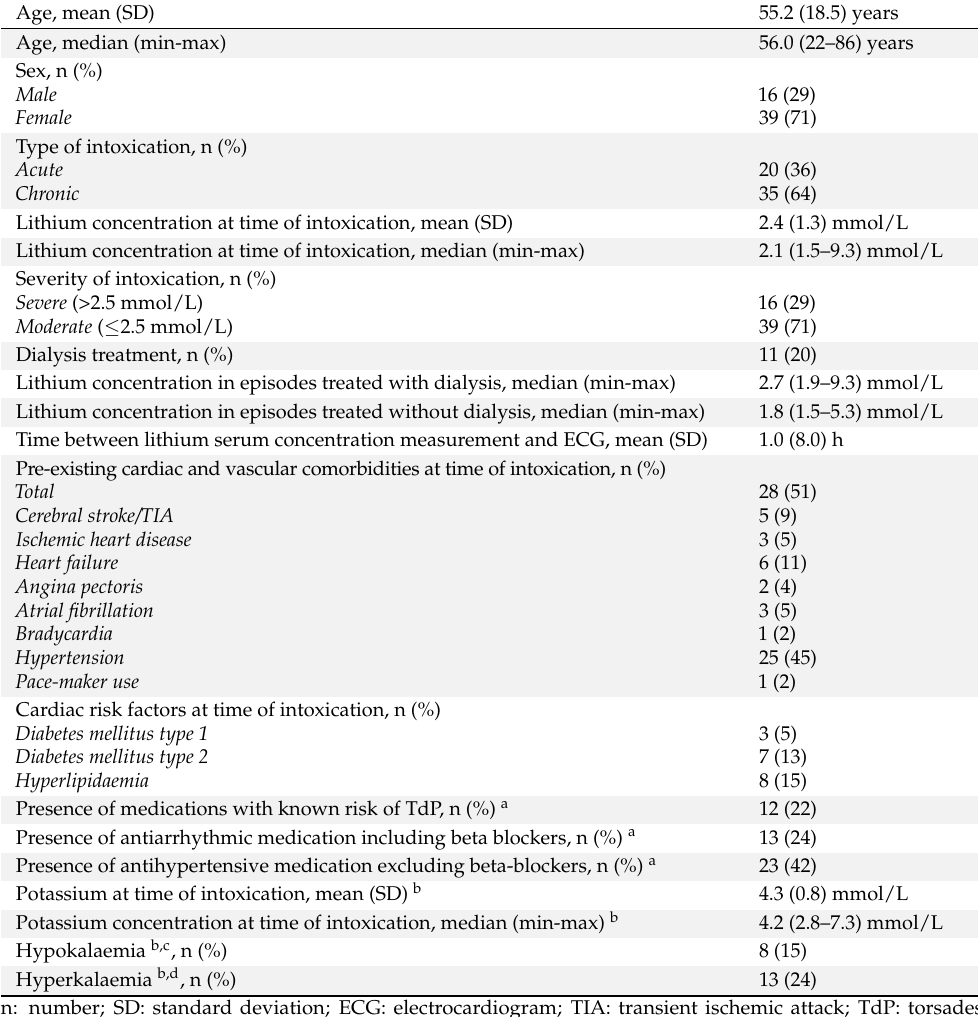
Table 3. Baseline characteristics of the sample at time of intoxication (n = 55